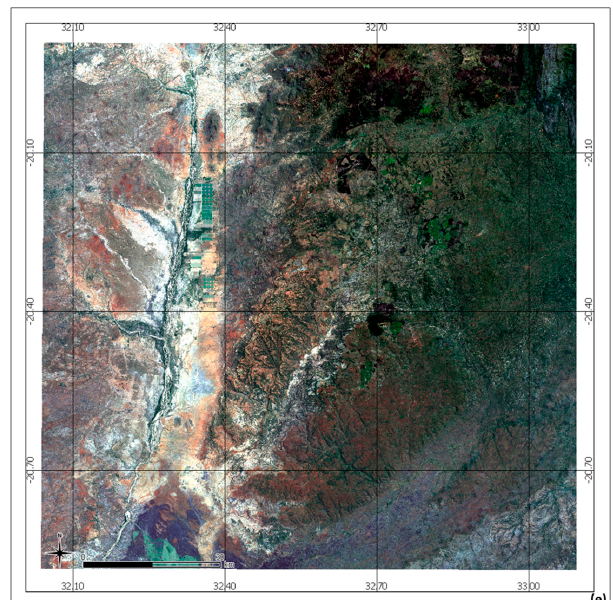
Figure 3. The figure shows the output of the Max-Normalised Difference Vegetation Index (NDVI) method, it selects the greenest value from quarterly intermediate products removing cloud shadows. ( a ) Darkest pixel composite for 1st Quarter 2016; ( b ) Darkest pixel composite for 2nd Quarter 2016; ( c ) Darkest pixel composite for 3rd Quarter 2016, on bottom right of the image is possible to observe how the clouds have been replaced by clear pixels even if the reflectance is higher respect to neighbour pixels; ( d ) Darkest pixel composite for 4th Quarter 2016; ( e ) Yearly composite based on Max-NDVI. © Contains modified Copernicus Sentinel data (2016)/Processed by ESA.